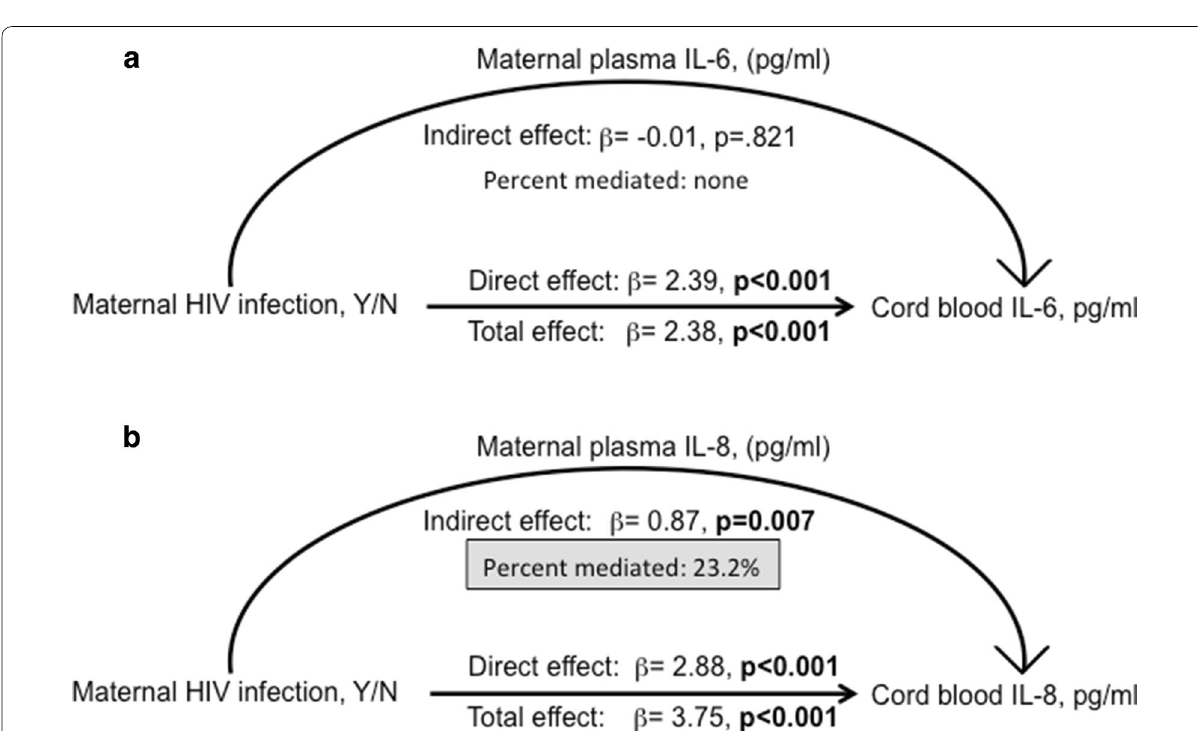
Fig. 3 Maternal HIV infection drives infant IL‑6 and IL‑8 levels present at birth in HEU infants through different pathways. SEM models with maternal HIV infection (yes/no), maternal IL‑8 levels at delivery in the pathway, and infant cord blood IL‑8 levels as the outcome variable for 42 mother‑infant pairs. HEU infants have 2.38 ln IL‑6 levels in cord blood at birth and none of the infant IL‑6 is attributable to maternal IL‑6 levels ( a ). HEU infants have 3.75 times ln IL‑8 levels in cord blood than detected in HU cord blood, and ~ 23% of this can be attributed to the maternal IL‑8 levels ( b